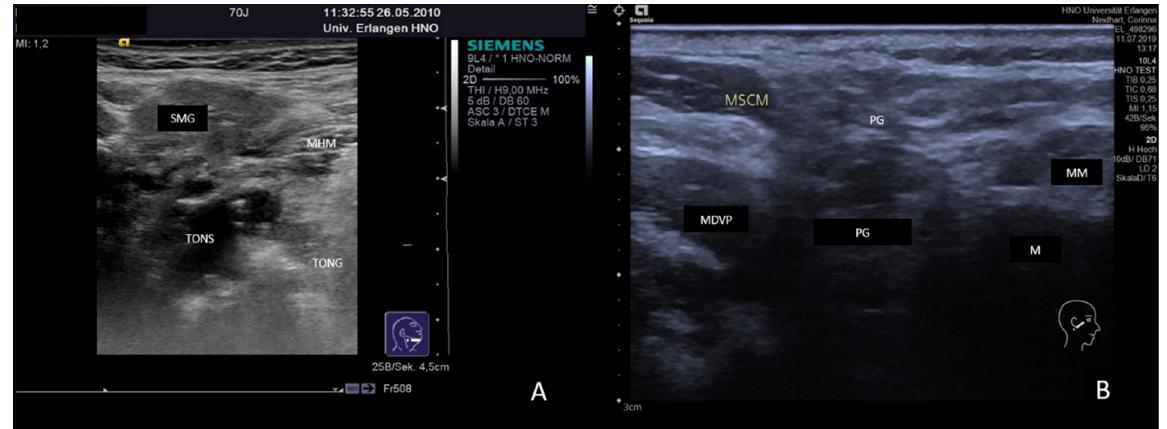
Figure 20. ( A , B ) Atrophy of the SMG after sialolithiasis ( A ) and of the PG after postoperative radiotherapy of the head and neck region ( B ). The gland parenchyma shows a markedly heterogeneous aspect. The SMG hyperechoic reflexes are presumably caused by scarring tissue, and hypoechoic areas indicating chronic inflammation are recognizable, which led to shrinkage of the gland volume ( A ). The image of the right-sided PG shows nearly no typical gland tissue any more. A degeneration of the parenchyma is visible, which is replaced by hypoechoic areas (presumably corresponding to fatty tissue) and by hyperechoic areas (presumably corresponding to fibrous tissue). Abbreviations: PG, parotid gland; SMG, submandibular gland; M, mandible; MM, masseter muscle; MSCM, sternocleidomastoid muscle; MHM, mylohyoid mus- cle; MDVP, digastric muscle venter posterior; TONG, tongue; TONS, tonsil.